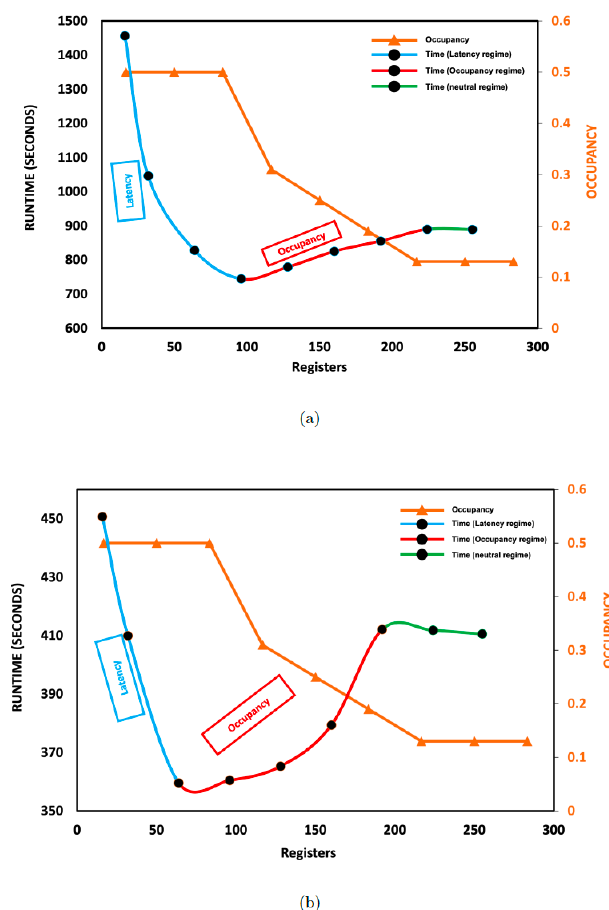
Figure 5. The WW3-W3SRCEMD.gpu runtime (primary vertical axis) and occupancy (secondary vertical axis in orange) based on register counts on Kodiak (a) and Summit (b) . For the runtime, the light blue part of the line represents the latency-dominant region, the red part represents the occupancy-dominant region, and the green part represents the neutral region. We analyzed the result of running a 228K mesh size on 16GPUs and